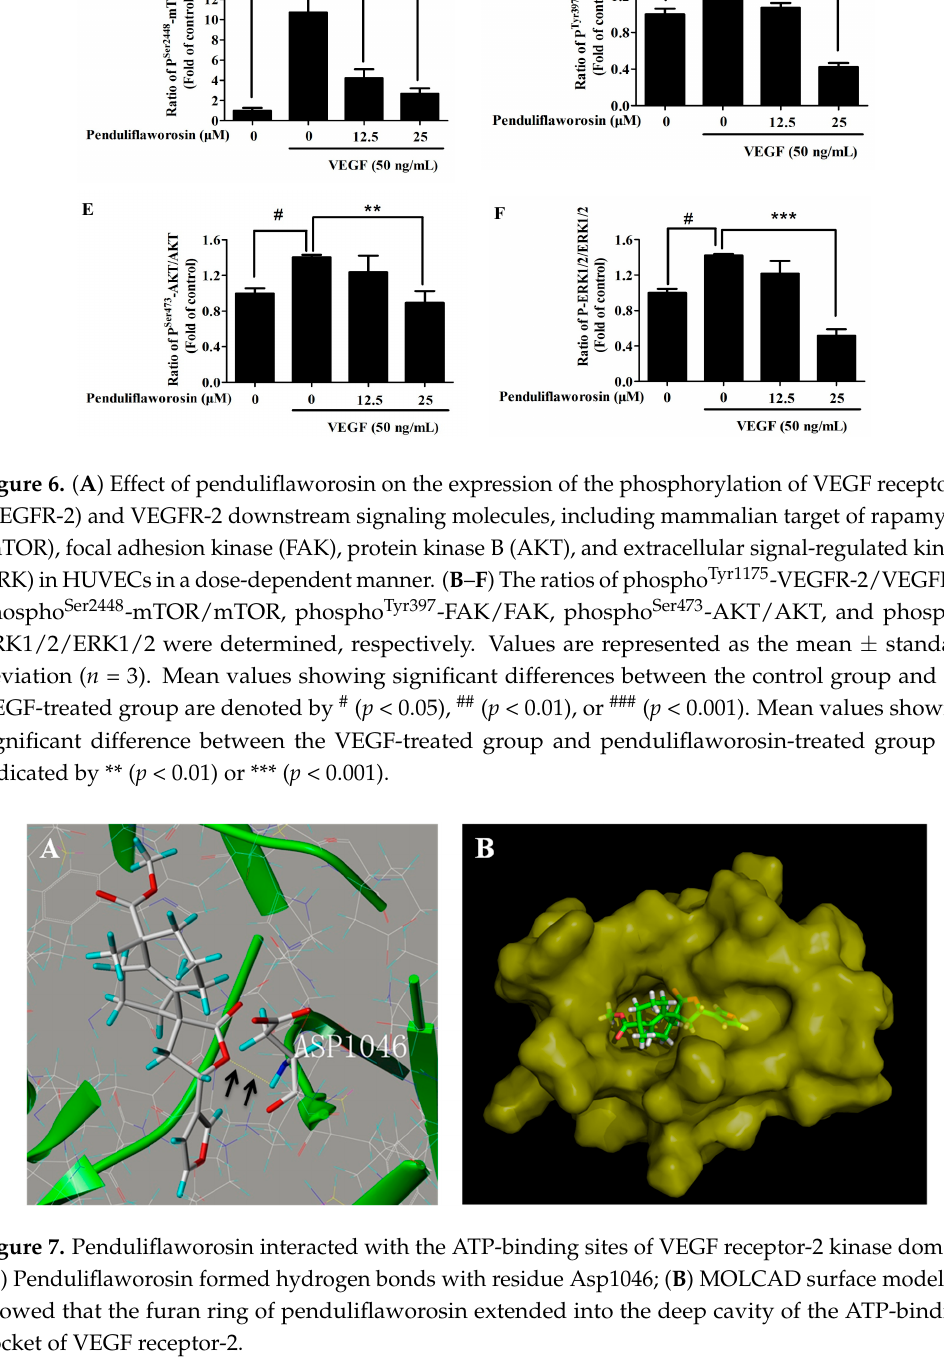
Figure 7. Penduliflaworosin interacted with the ATP-binding sites of VEGF receptor-2 kinase domain. ( A ) Penduliflaworosin formed hydrogen bonds with residue Asp1046. ( B ) MOLCAD surface modeling showed that the furan ring of penduliflaworosin extended into the deep cavity of the ATP-binding pocket of VEGF receptor-2.